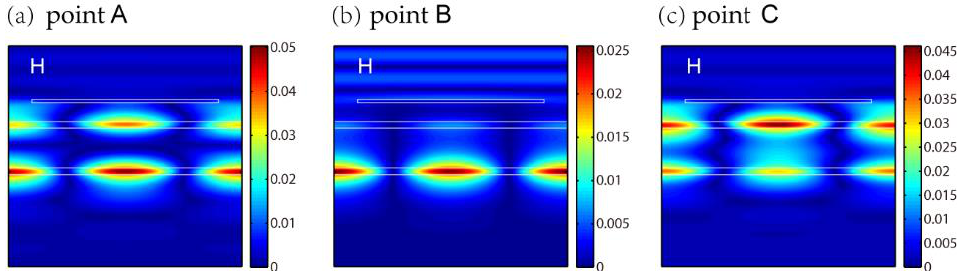
300 nm t  and 300 nm t  and 1 1